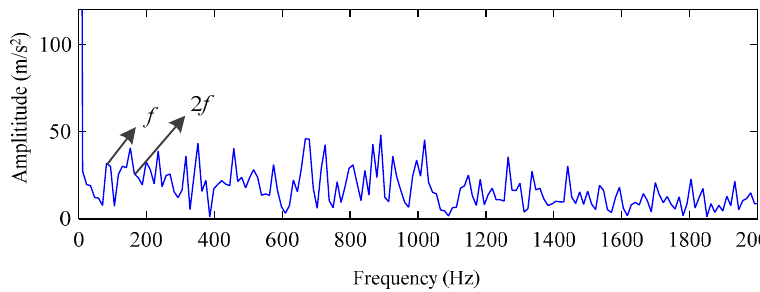
Figure 11. Envelope spectrum of optimal component by using EEMD.